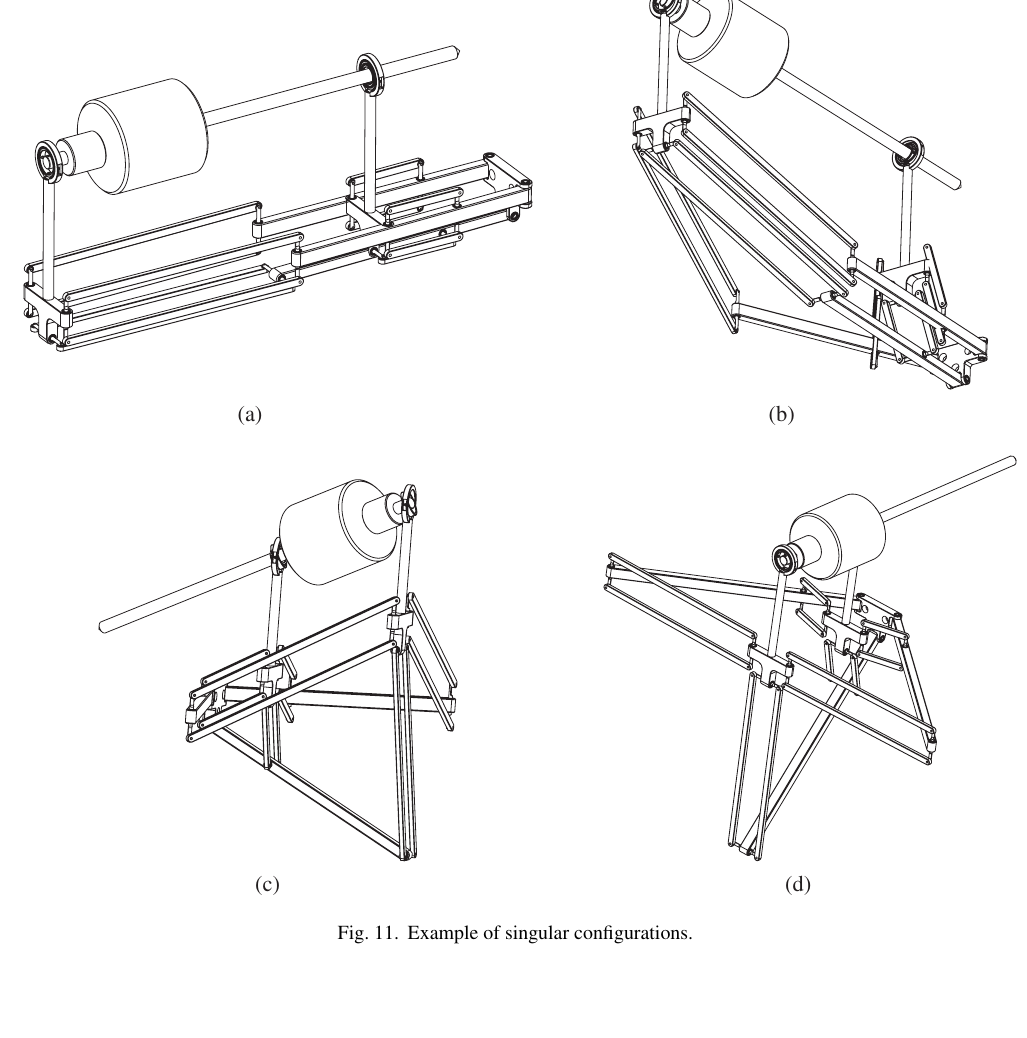
Fig. 11. Example of singular